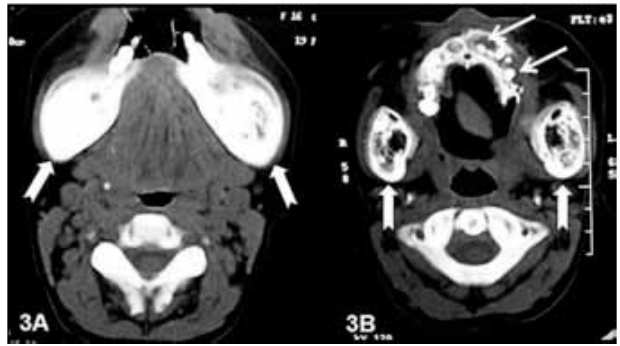
Fig. 3. CT of the face (3A and 3B) show bulky rami of the mandible with mandibular retrognathism (thick white arrows). Microdontia, partial anodontia, enamel hypoplasia, multiple caries and early tooth loss are seen (thin white